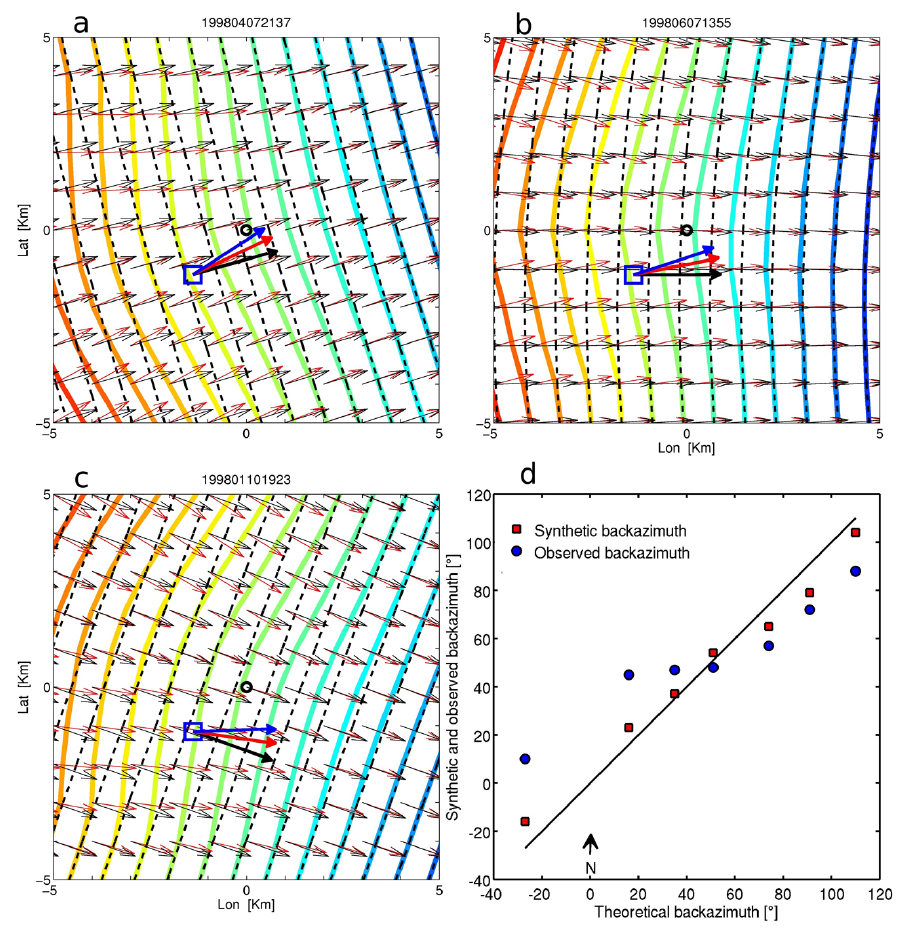
Figure 8. Plots a , b , and c show the synthetic wavefronts elaborated for the last three earthquakes listed in Table 1, similar to those shown in Figure 7. Plot d display observed and synthetic backazimuth versus the theoretical backazimuth for the seven earthquakes analyzed in this